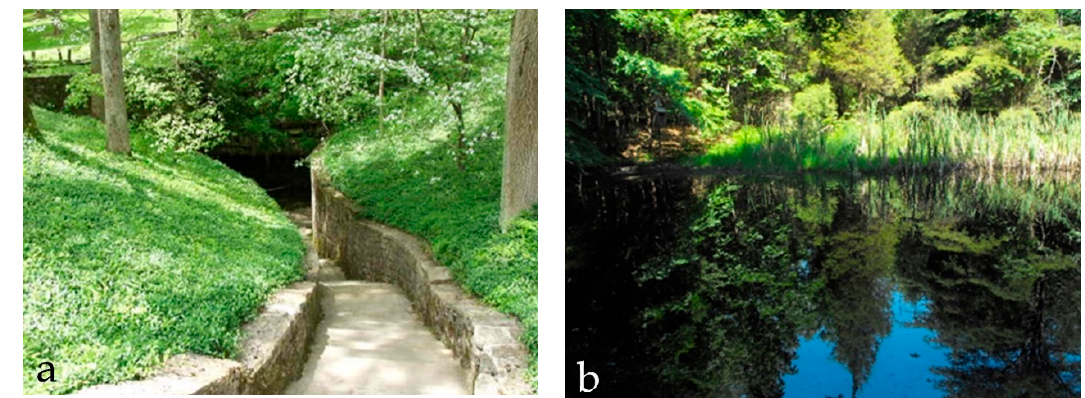
Figure 4. The sampling locations #1 ( a ) and #2 ( b ) from the Abraham Lincoln Birthplace National Historical Park in Kentucky, USA.